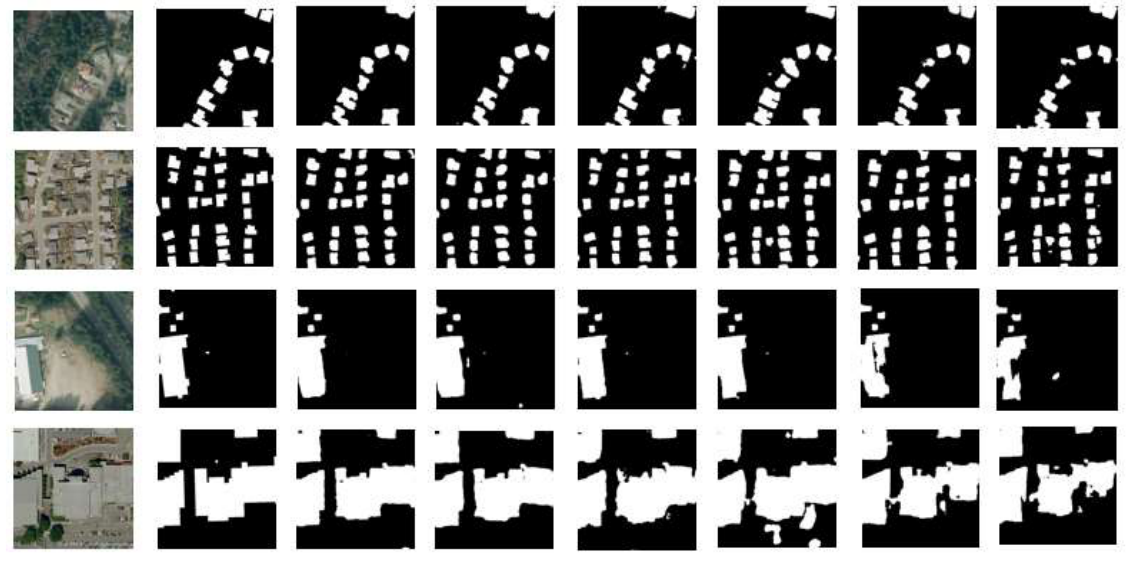
Figure 5. Visualization of building extraction results by different models on the Inria